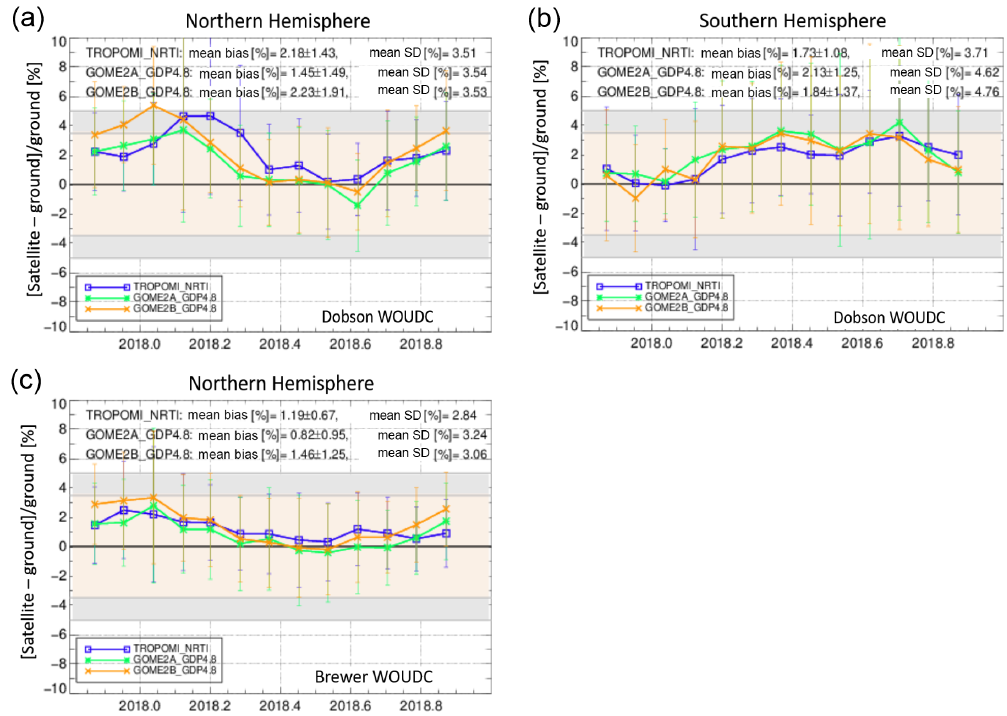
Figure 14. As in Fig. 12 but for the time series of the percentage differences between TROPOMI NRTI (blue line), GOME2A (green line) and GOME2B (orange line); the latter two are processed with the GDP 4.8 algorithm.